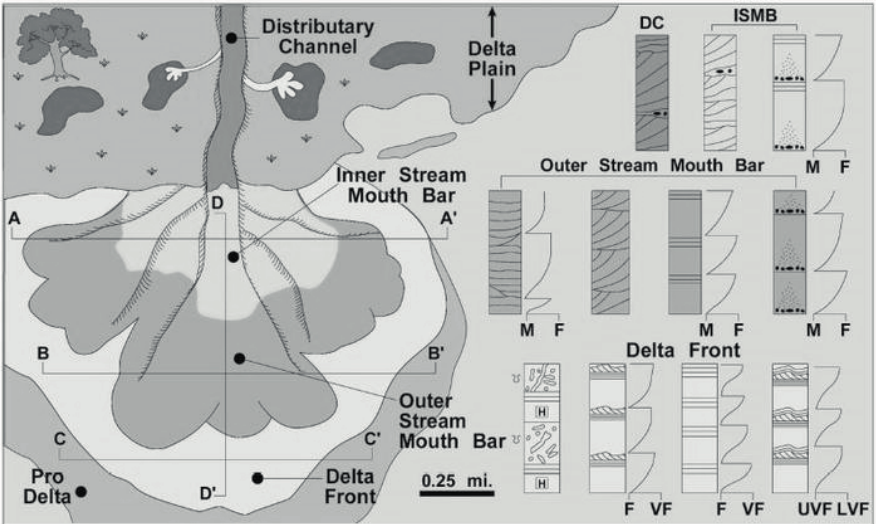
Fig. 3 Wax Lake Delta mineral and organic sediment characteristics; from Wellner et al .,